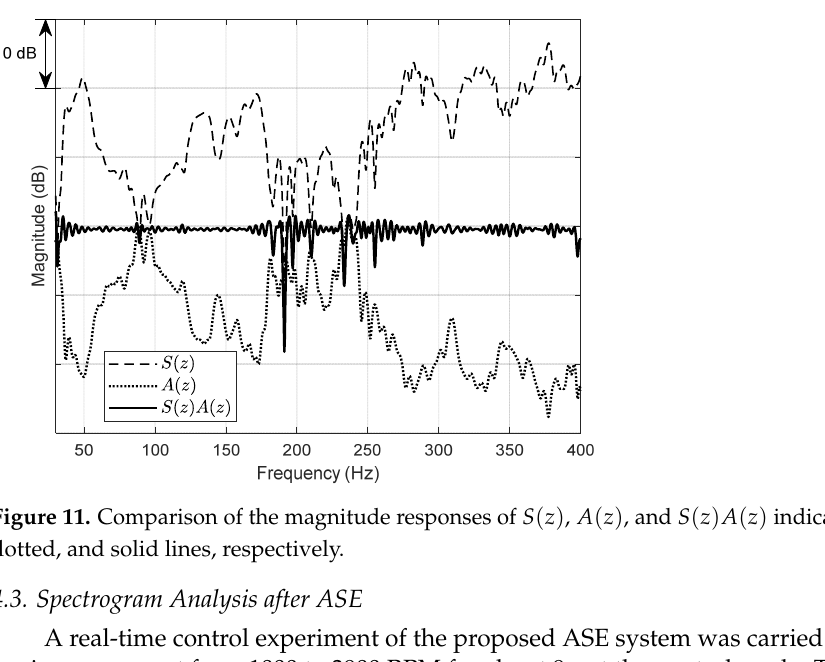
dotted, and solid lines, respectively. dashed,